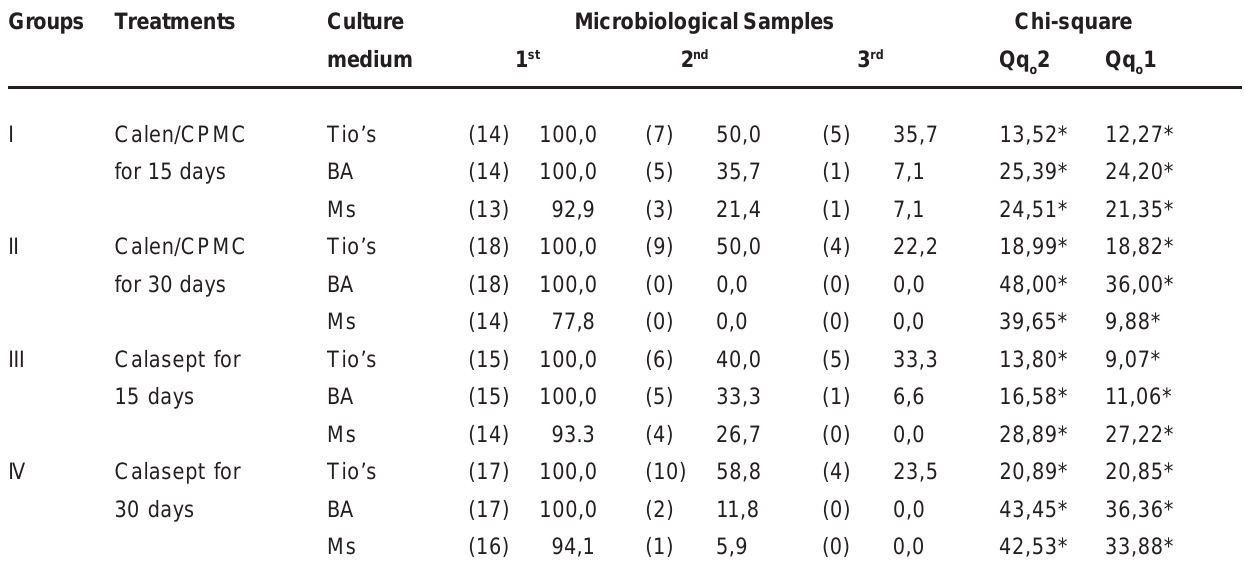
TABLE 3- Frequencies of positive microbiological cultures in Tio’s, BA and Ms culture medium as a function of treatment